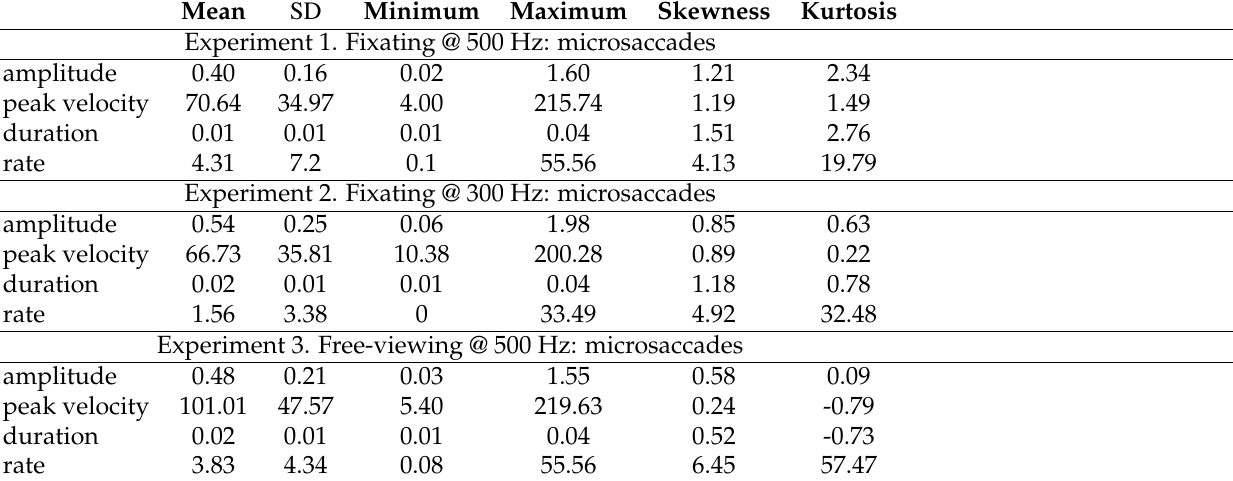
Descriptive statistics of microsaccade parameters: amplitude (deg), peak velocity (deg/sec), duration (sec), and rate (count/sec) from Experiments 1, 2, and 3.